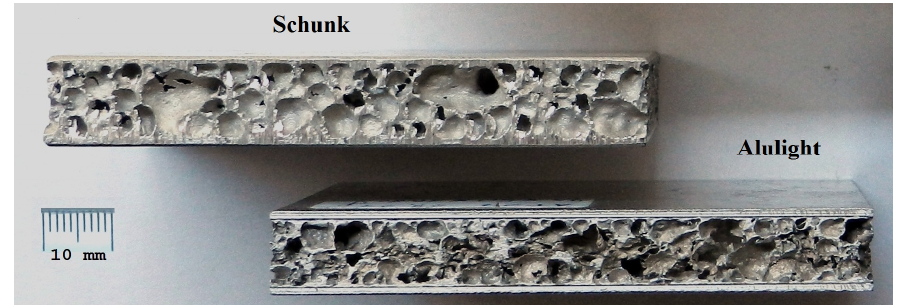
Figure 1. Aluminum foam sandwiches (AFS)